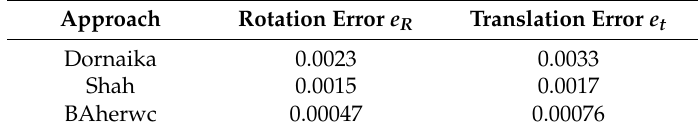
Table 4. Error comparison in rotation and translation for the photogrammetric scene dataset.